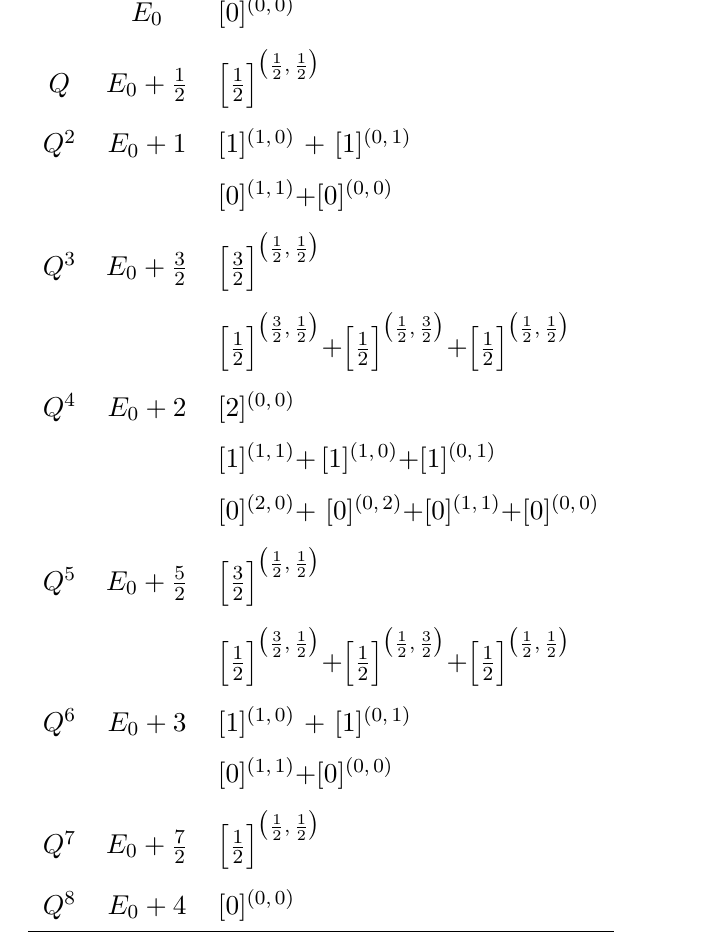
Table 3 . States in the long graviton supermultiplet LGRAV 4 [ E 0 , 0 , 0]